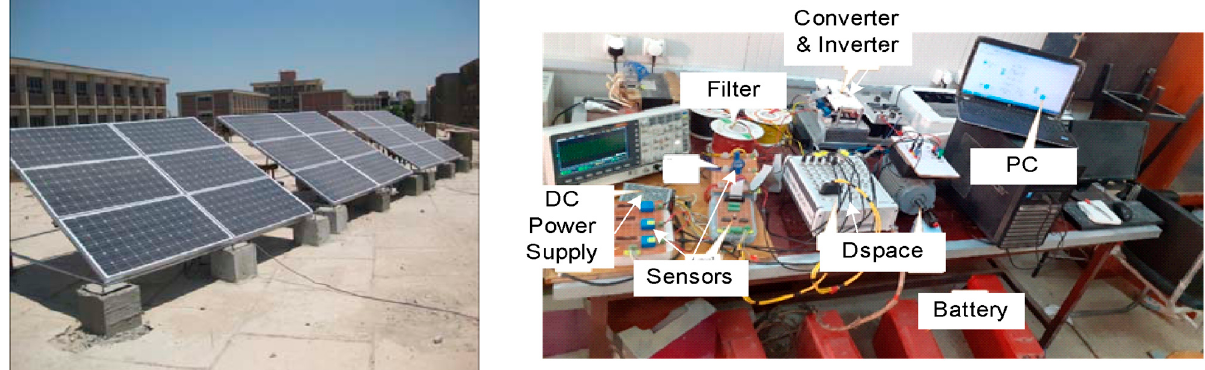
Figure 14. PV system setup.